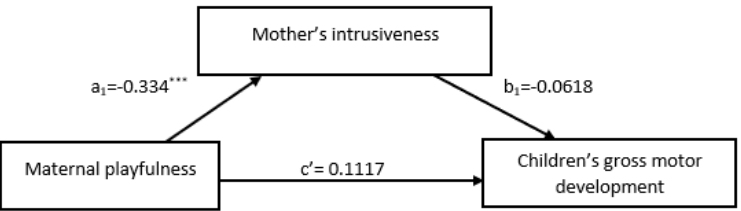
Figure 2. Effect of maternal playfulness on children’s communication development mediated by mothers’ intrusiveness. Asterisks (***) indicate the significance effect of maternal playfulness on mother’s intrusiveness ( p < 0.001) (a1).